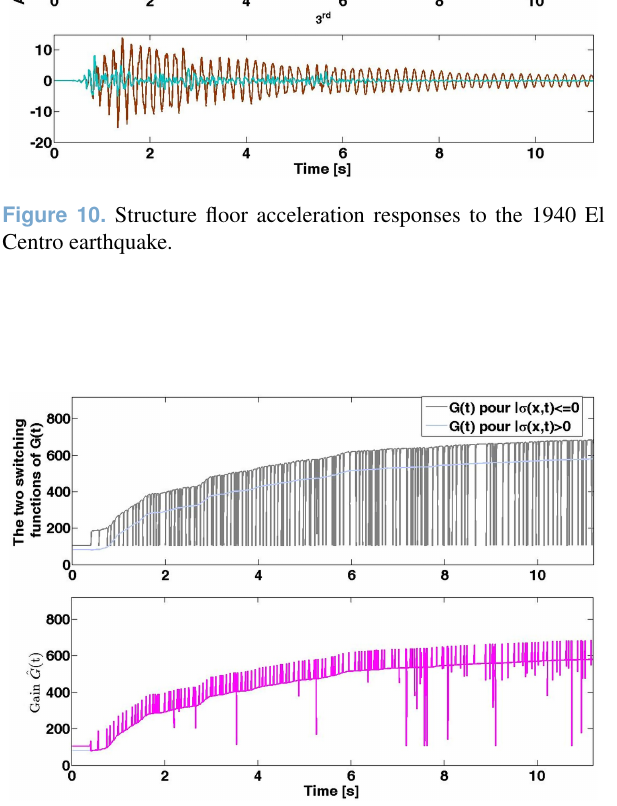
Figure 11. Time response of adaptive control gain under the 1940 El Centro earthquake.